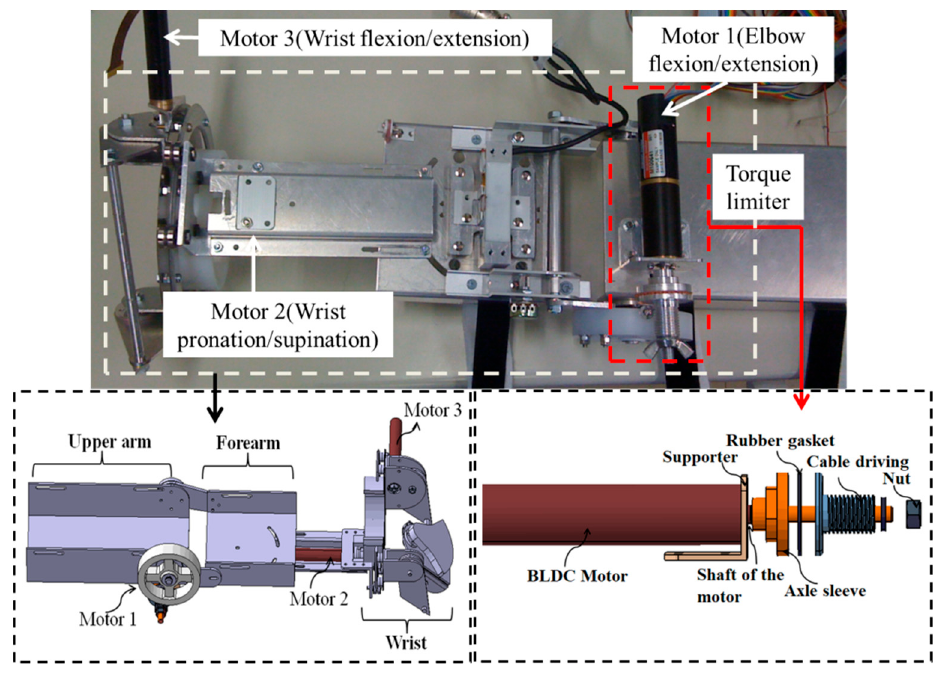
Figure 3. The exoskeleton device (lower view).